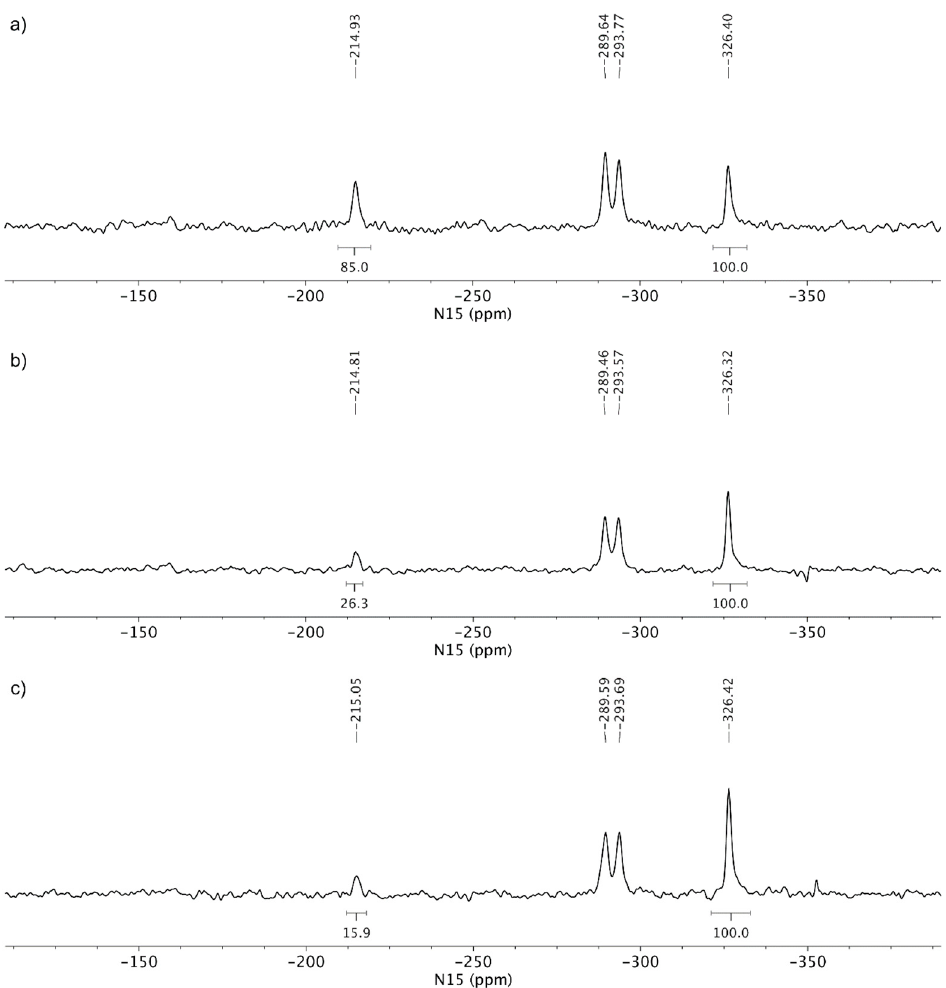
Figure 10. 15 N LG-CP MAS NMR spectra of different samples of TA MF1: ( a ) the majority of samples contains salt species, ( b ) the sample contains approximately 30% of salt species and ( c ) the sample contains approximately 20% of salt species. All spectra were acquired using a relaxation delay of 1 s and ca. 200,000 scans. The relative integral value of protonated purine nitrogen is reported with respect to the integral region of amine nitrogen, which was arbitrarily set at 100.